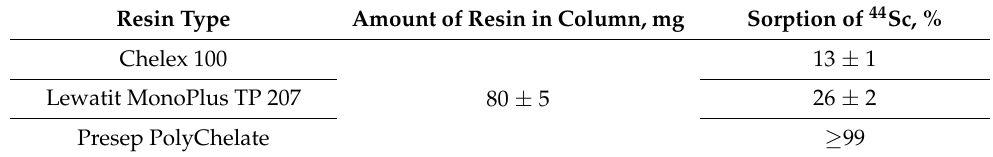
Table 4. Sorption of 44 Sc from TEVA-based 44 Ti/ 44 Sc generator eluate on different chelating resins. Resin Type Amount of Resin in Column, mg